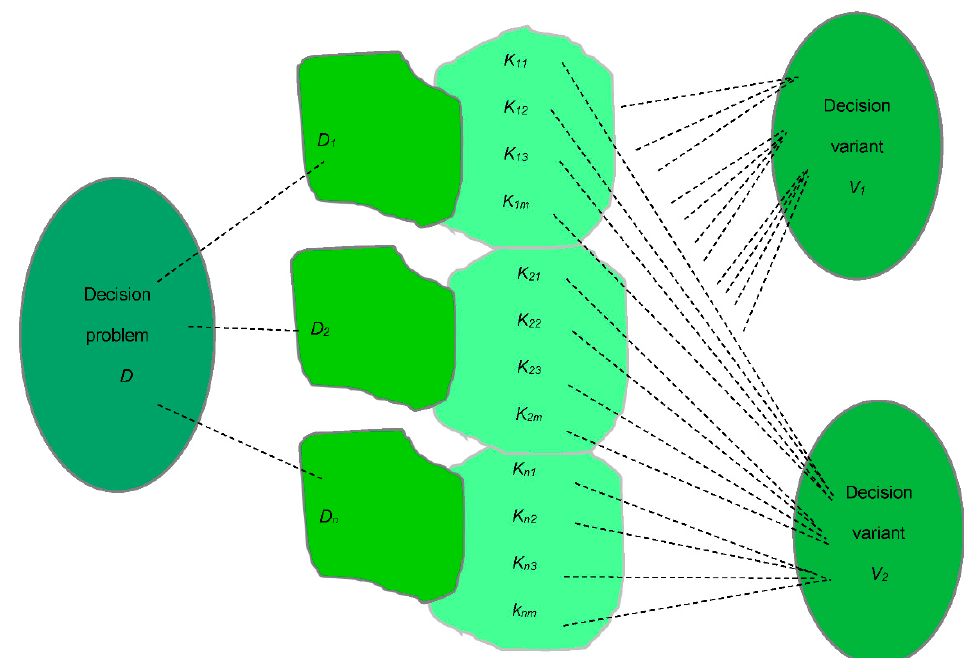
Figure 2. Model of a decision-making process with a hierarchical structure.